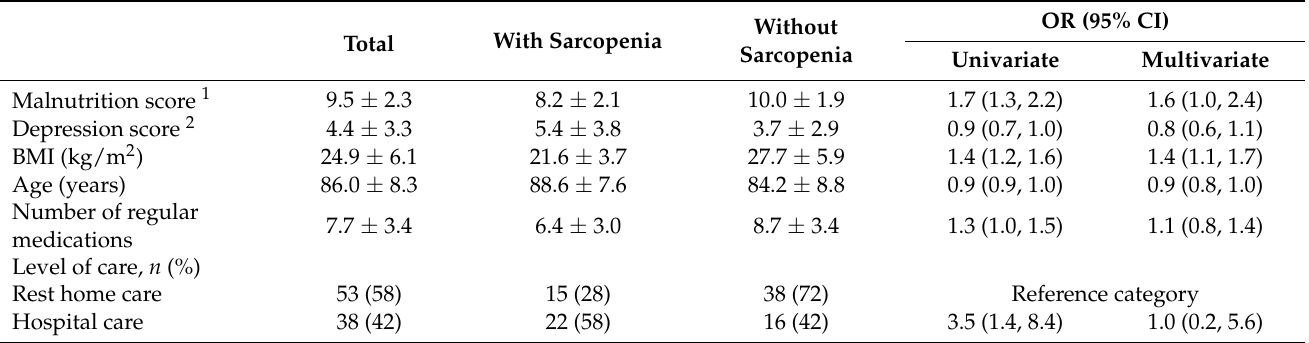
Table 4. Factors predicting sarcopenia using a regression model including